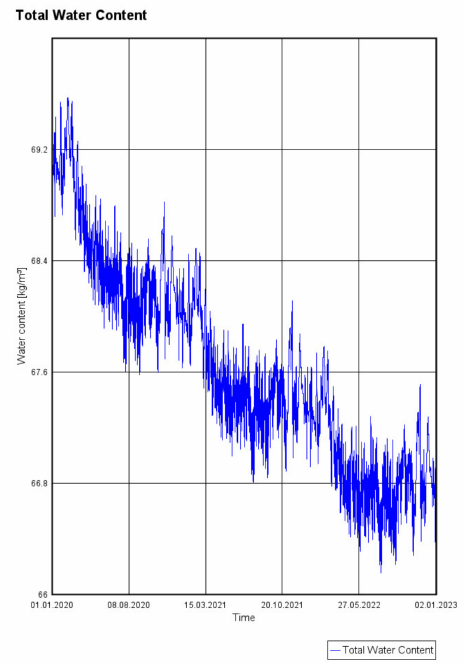
Figure 20. Changes in water content—partition insulated with mineral wool.